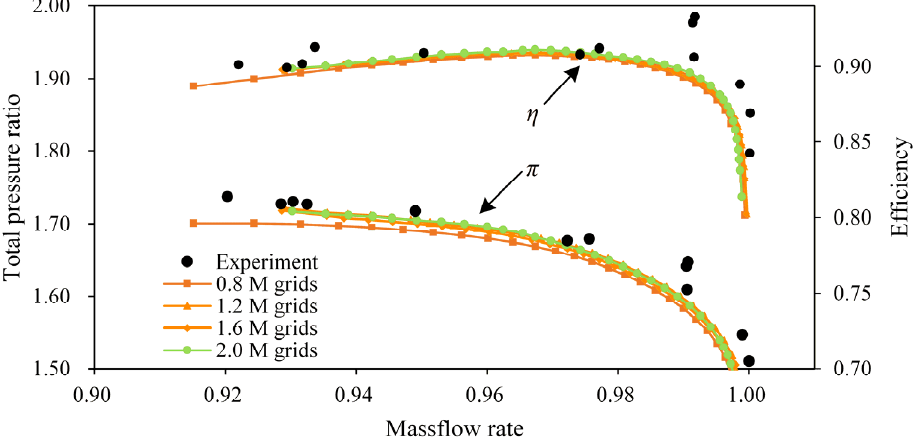
Figure 3. Operating characteristics of NASA Rotor 67 with 0.8 M, 1.2 M, 1.6 M, and 2.0 M grids.